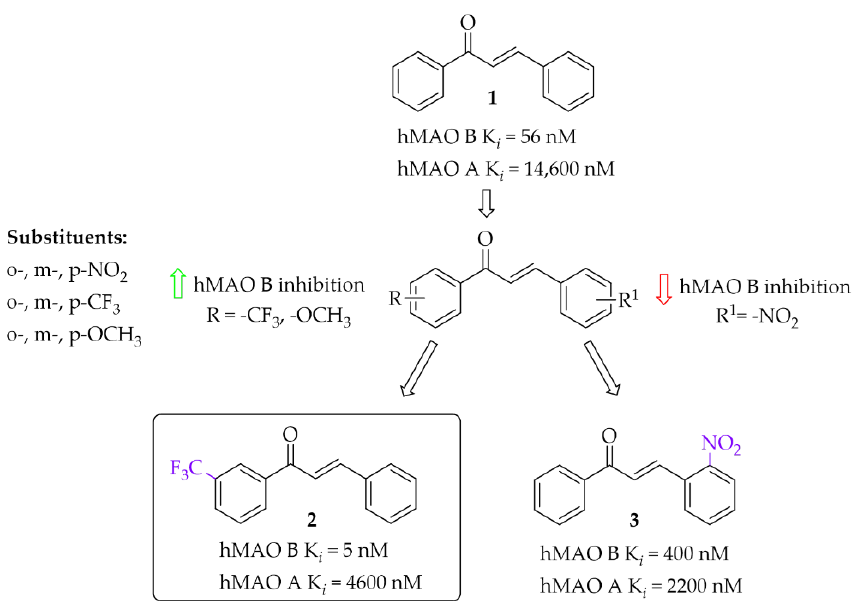
Figure 7. Mono-modification of chalcone ring — the effect of substituents on the inhibitory activity of human MAO B [27].